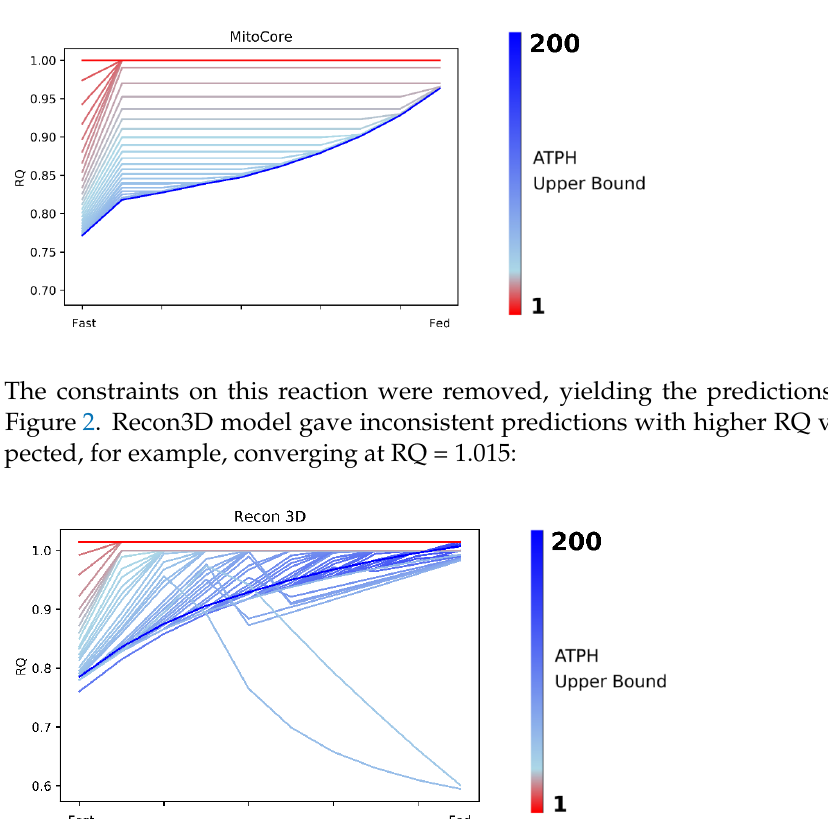
lower ATPH UB values: